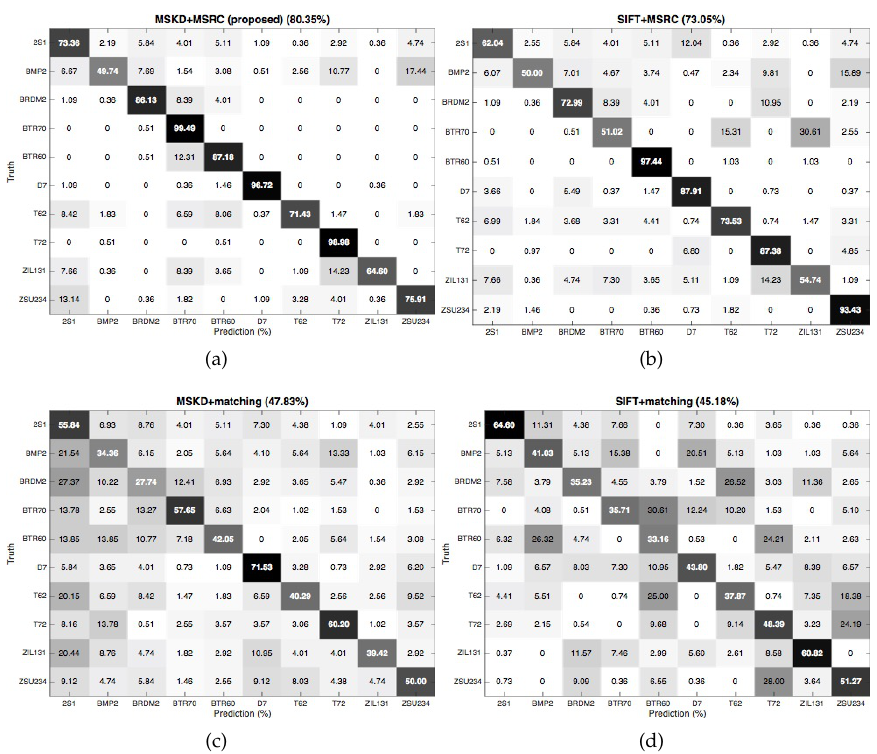
Figure 8. Confusion matrix of the different methods on MSTAR dataset under SOC: ( a ) MSKD +